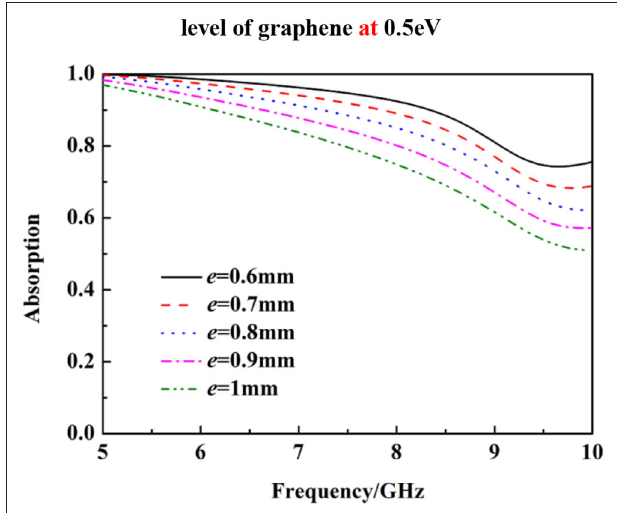
FIGURE 12 | The absorption of the metamaterial absorber under different structural dimension parameters e with the Fermi level of graphene at 0.5eV.